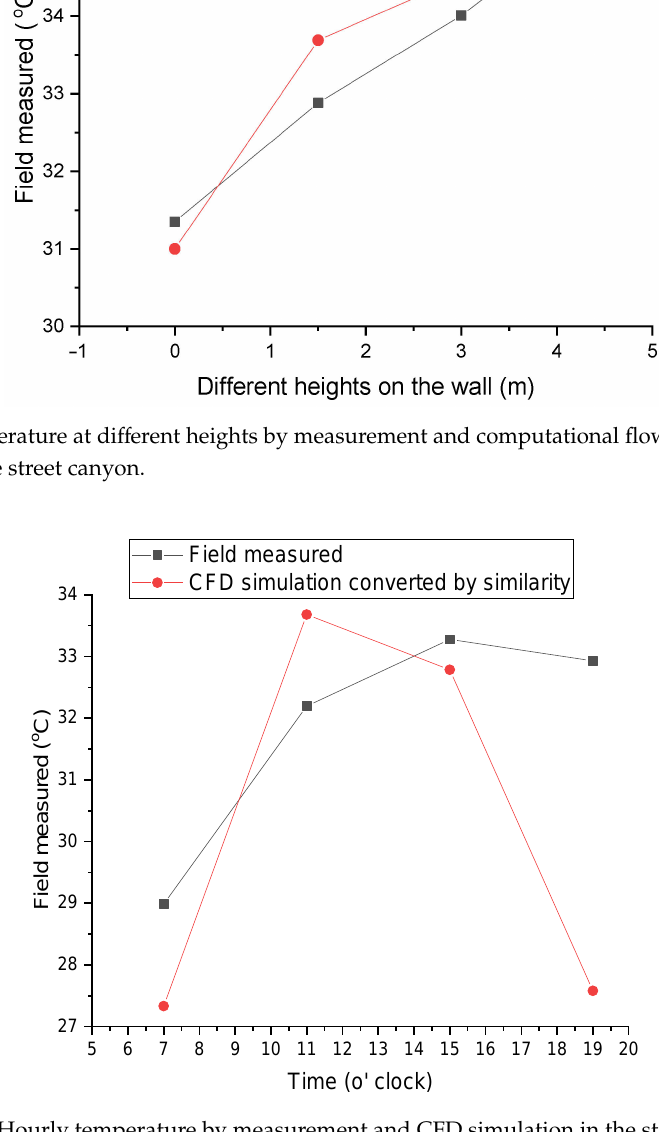
Figure 15. Hourly temperature by measurement and CFD simulation in the street canyon.